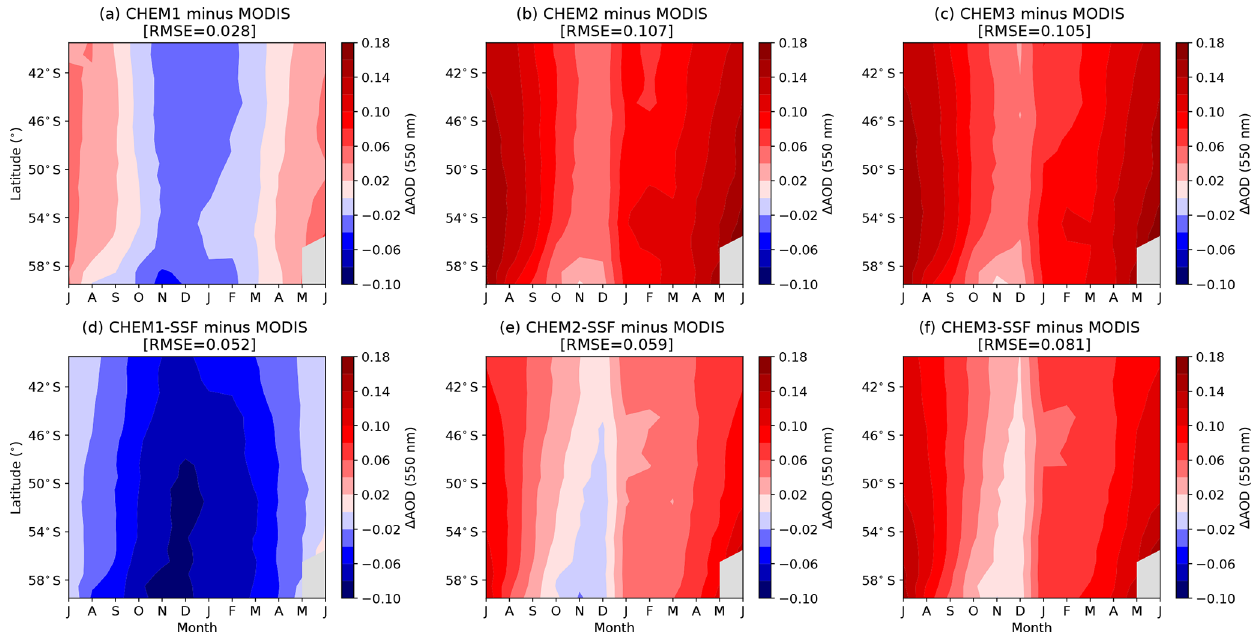
Figure 11. The difference in climatological monthly-mean AOD over the Southern Ocean between MODIS and the HadGEM3-GA7.1 sensitivity simulations: (a) CHEM1; (b) CHEM2; (c) CHEM3; (d) CHEM1-SSF; (e) CHEM2-SSF; (f) CHEM3-SSF. The RMSE is indicated in the